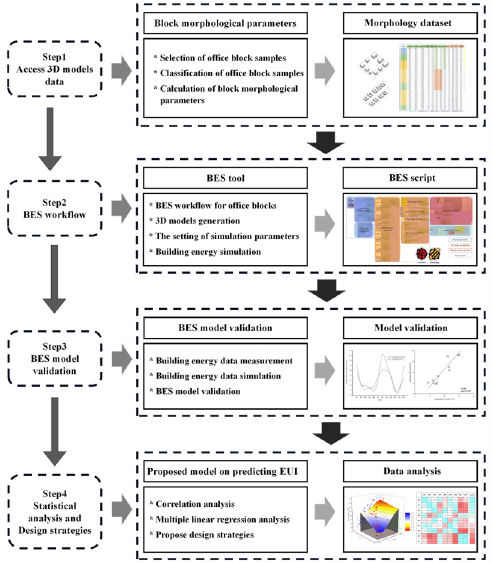
Figure 4. Workflow of holistic approach with four major steps.